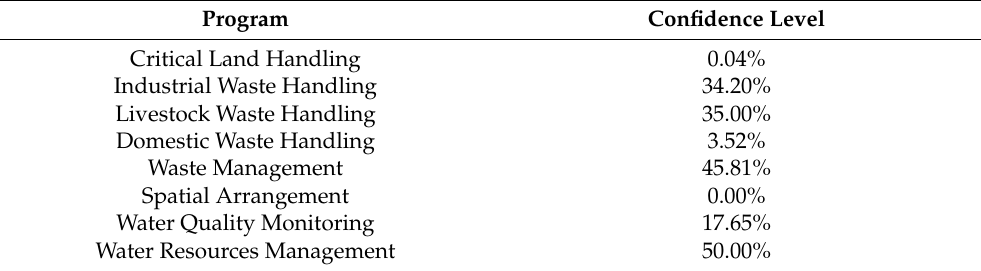
Table 4. Confidence level in the pollution control program’s